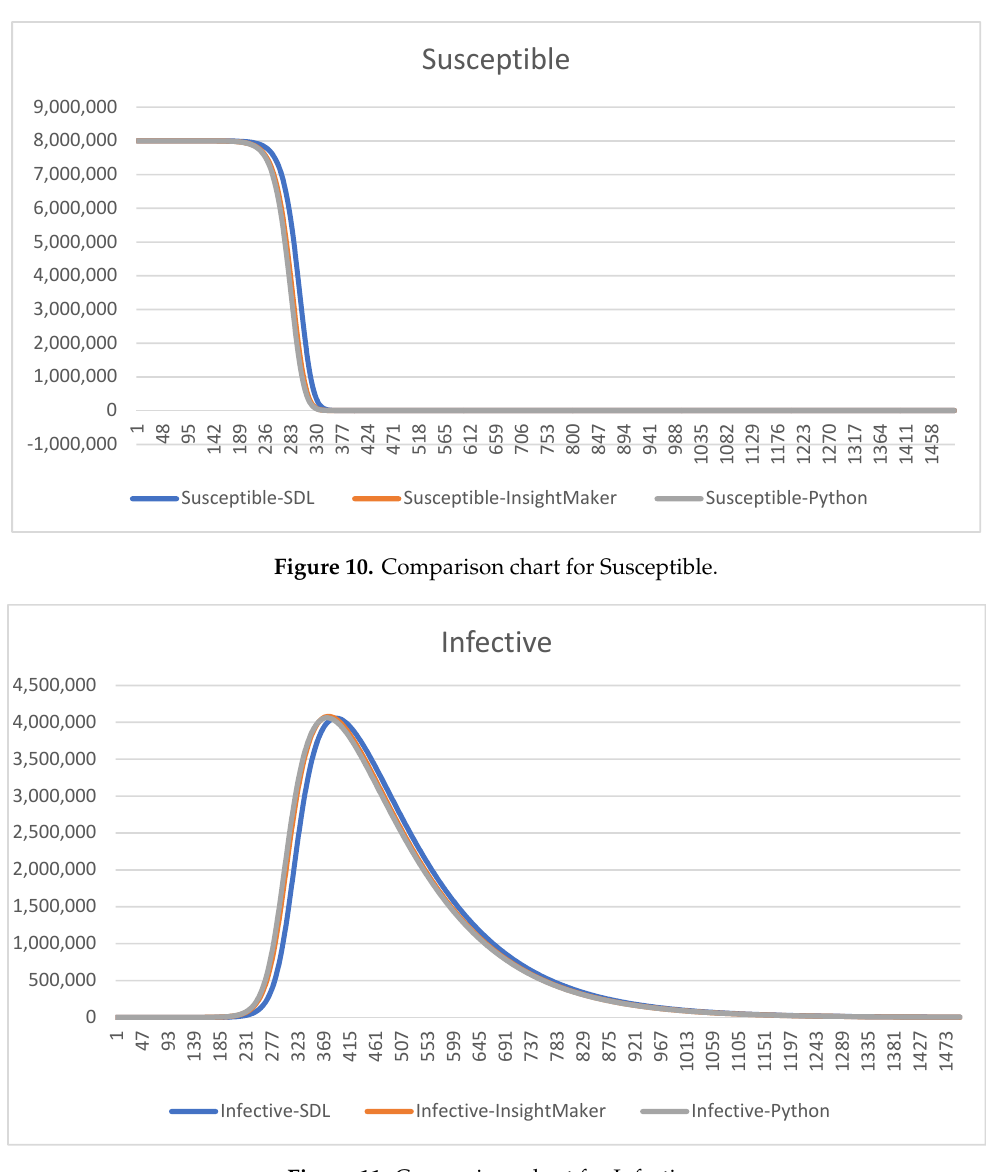
11 of 19 Table 1. Parameters for the validation between the different models. Parameter